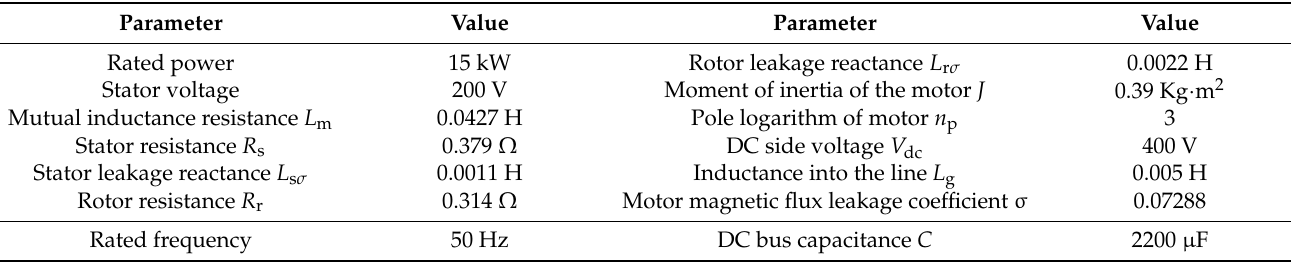
Figure 7. Frequency response of RSC F 1 ( s ) based on resonant control. Table 1. DFIG experimental platform-related parameters.